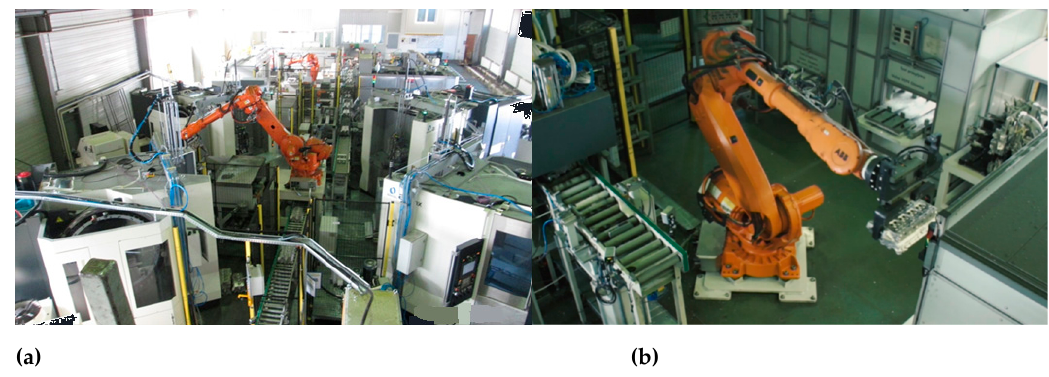
Figure 8. Robotized manufacturing line ( a ) main machining cell, ( b ) testing station. Figure 8 . Robotized manufacturing line a ) main machining cell, b ) testing station.